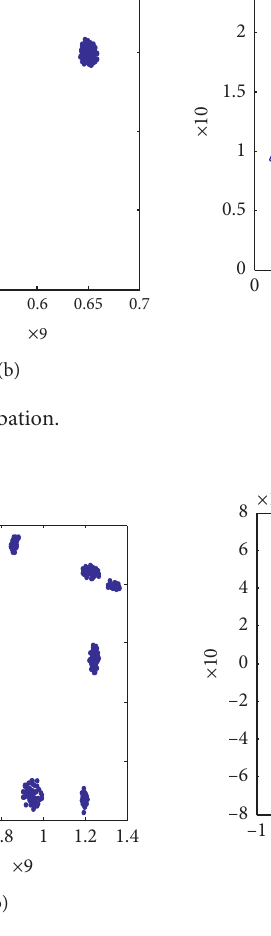
Figure 41: ω � 200 with random perturbation.